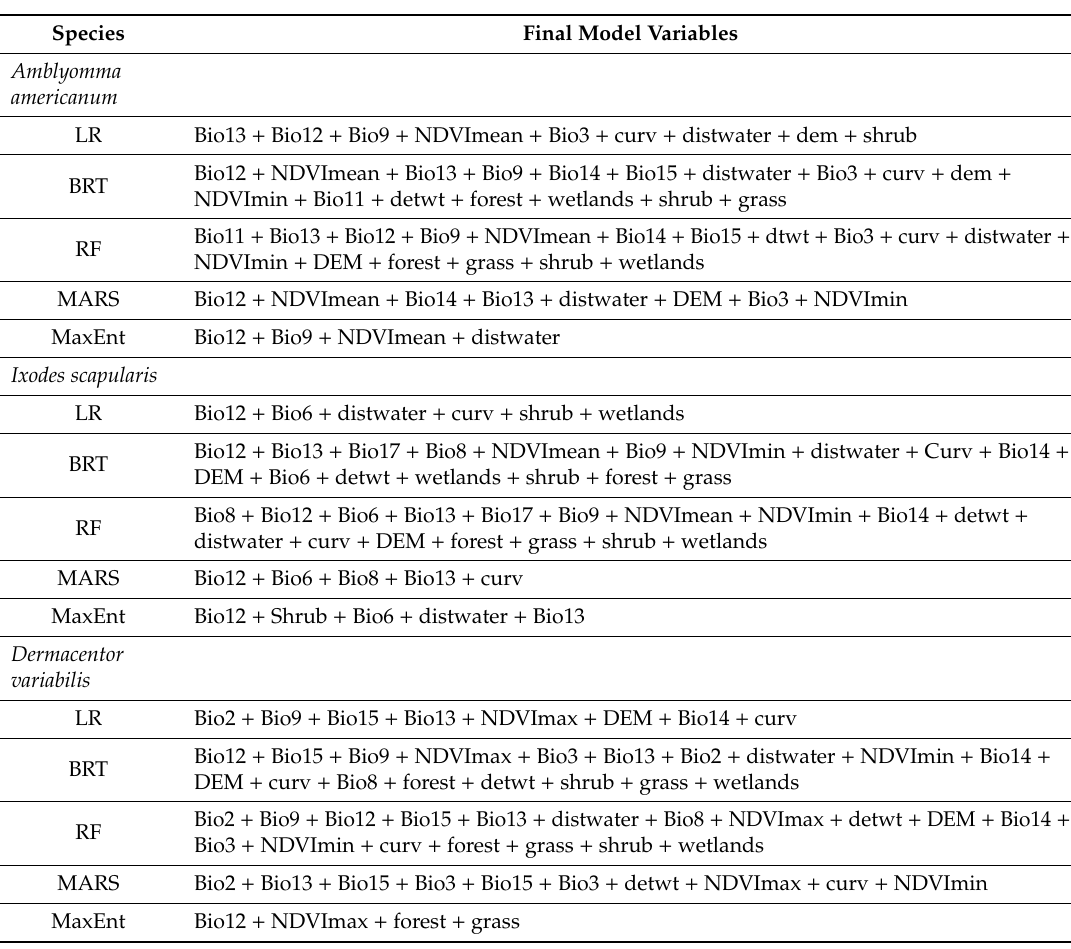
Table 3. Variables included in final models for each species. The machine learning algorithms consider all variables initially, and unimportant variables are pruned back. As a result, all considered variables are listed for these models, though the contribution of some variables is quite